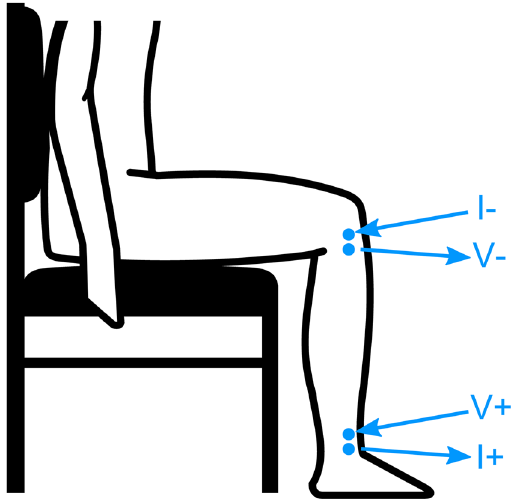
Figure 6. Position of the bioelectrical impedance electrodes on the lower leg. I + and I − represent electrodes applying current, while V + and V − are the electrodes measuring the voltage across the lower